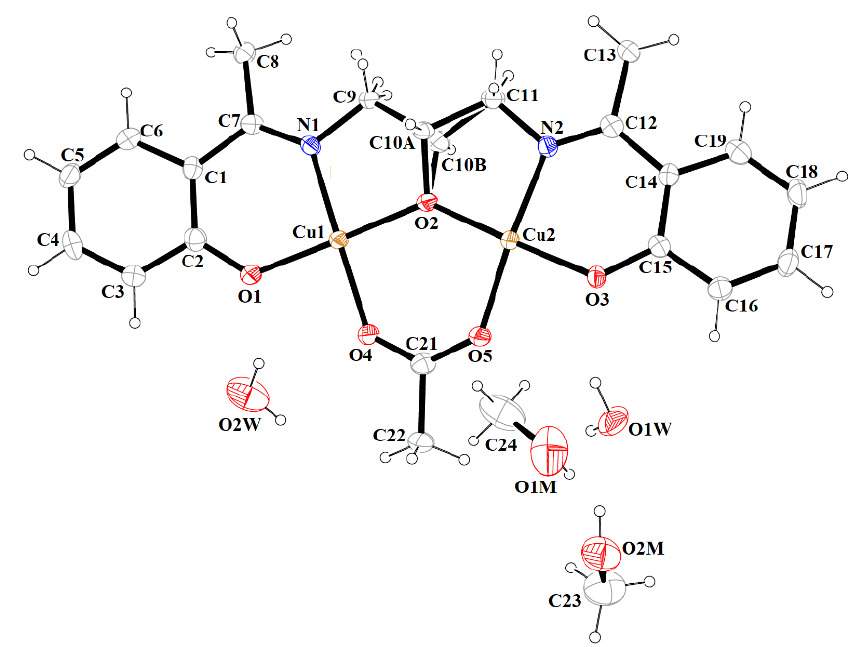
Figure 9. A view of asymmetric unit of 4, showing the atom-numbering scheme. Displacement ellipsoids are drawn at the 60% probability level.